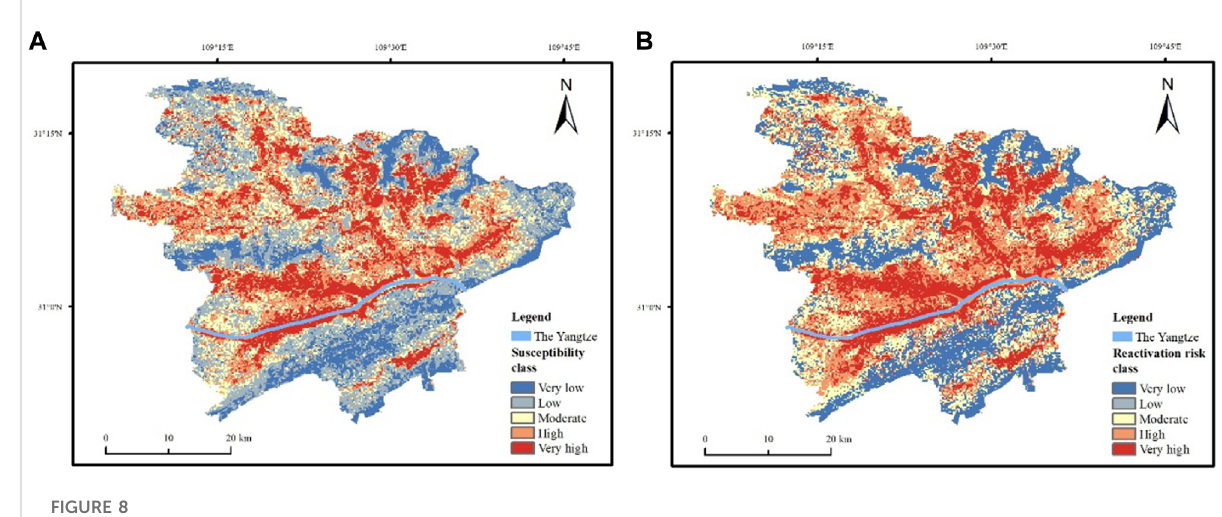
FIGURE 8 Landslide maps at different scales. (A) Long-time scale landslide susceptibility map (B) Cross-time scale landslide risk